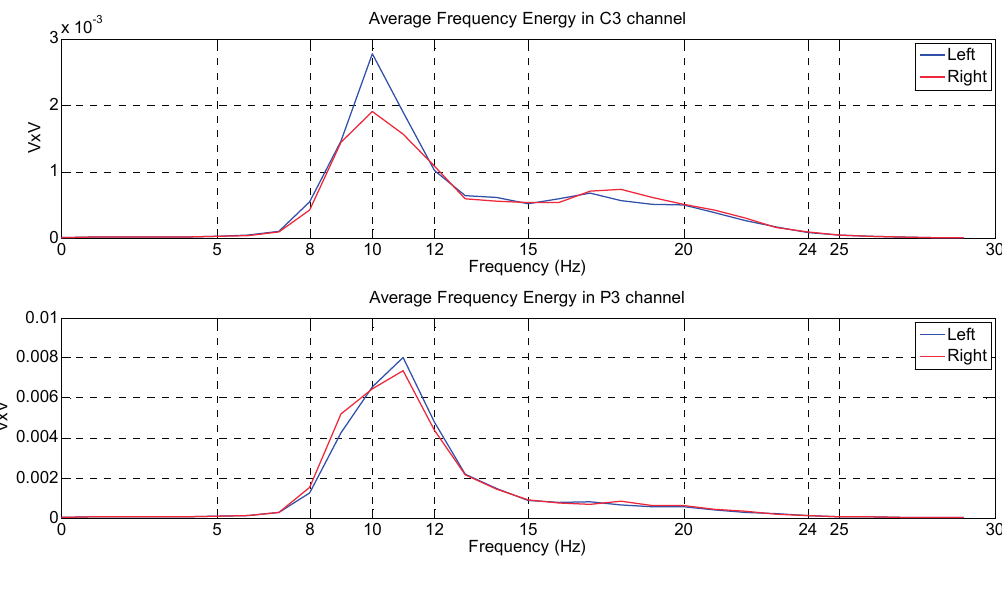
Figure 9. Average energy on the frequency domain for channels C3 and P3.